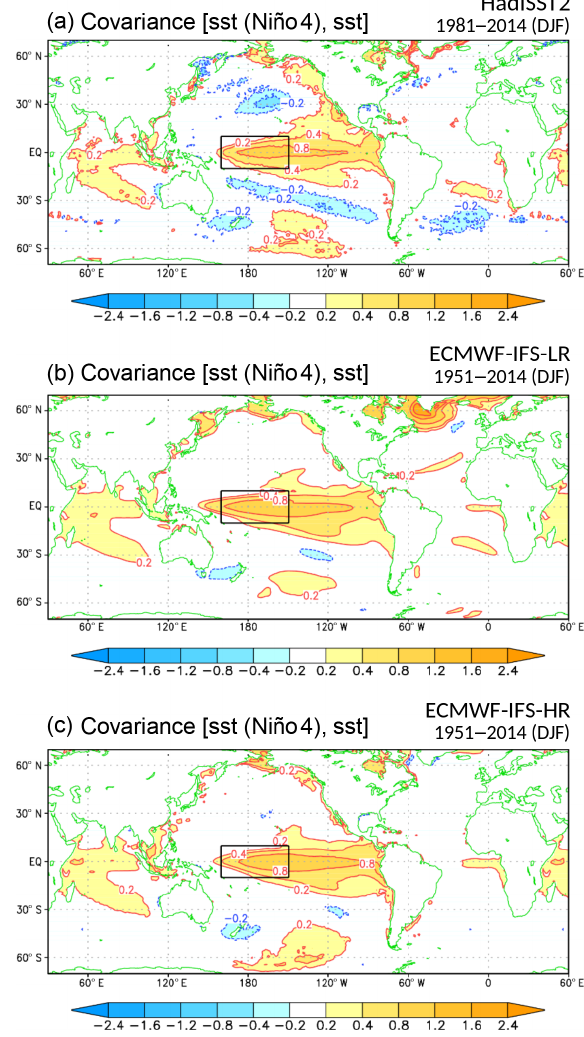
Figure 18. Covariance of DJF SST anomalies with the nor- malized time series of SST anomaly in the Niño4 region for (a) HadISST2 and all members of hist-1950 in (b) ECMWF-IFS- LR and (c)